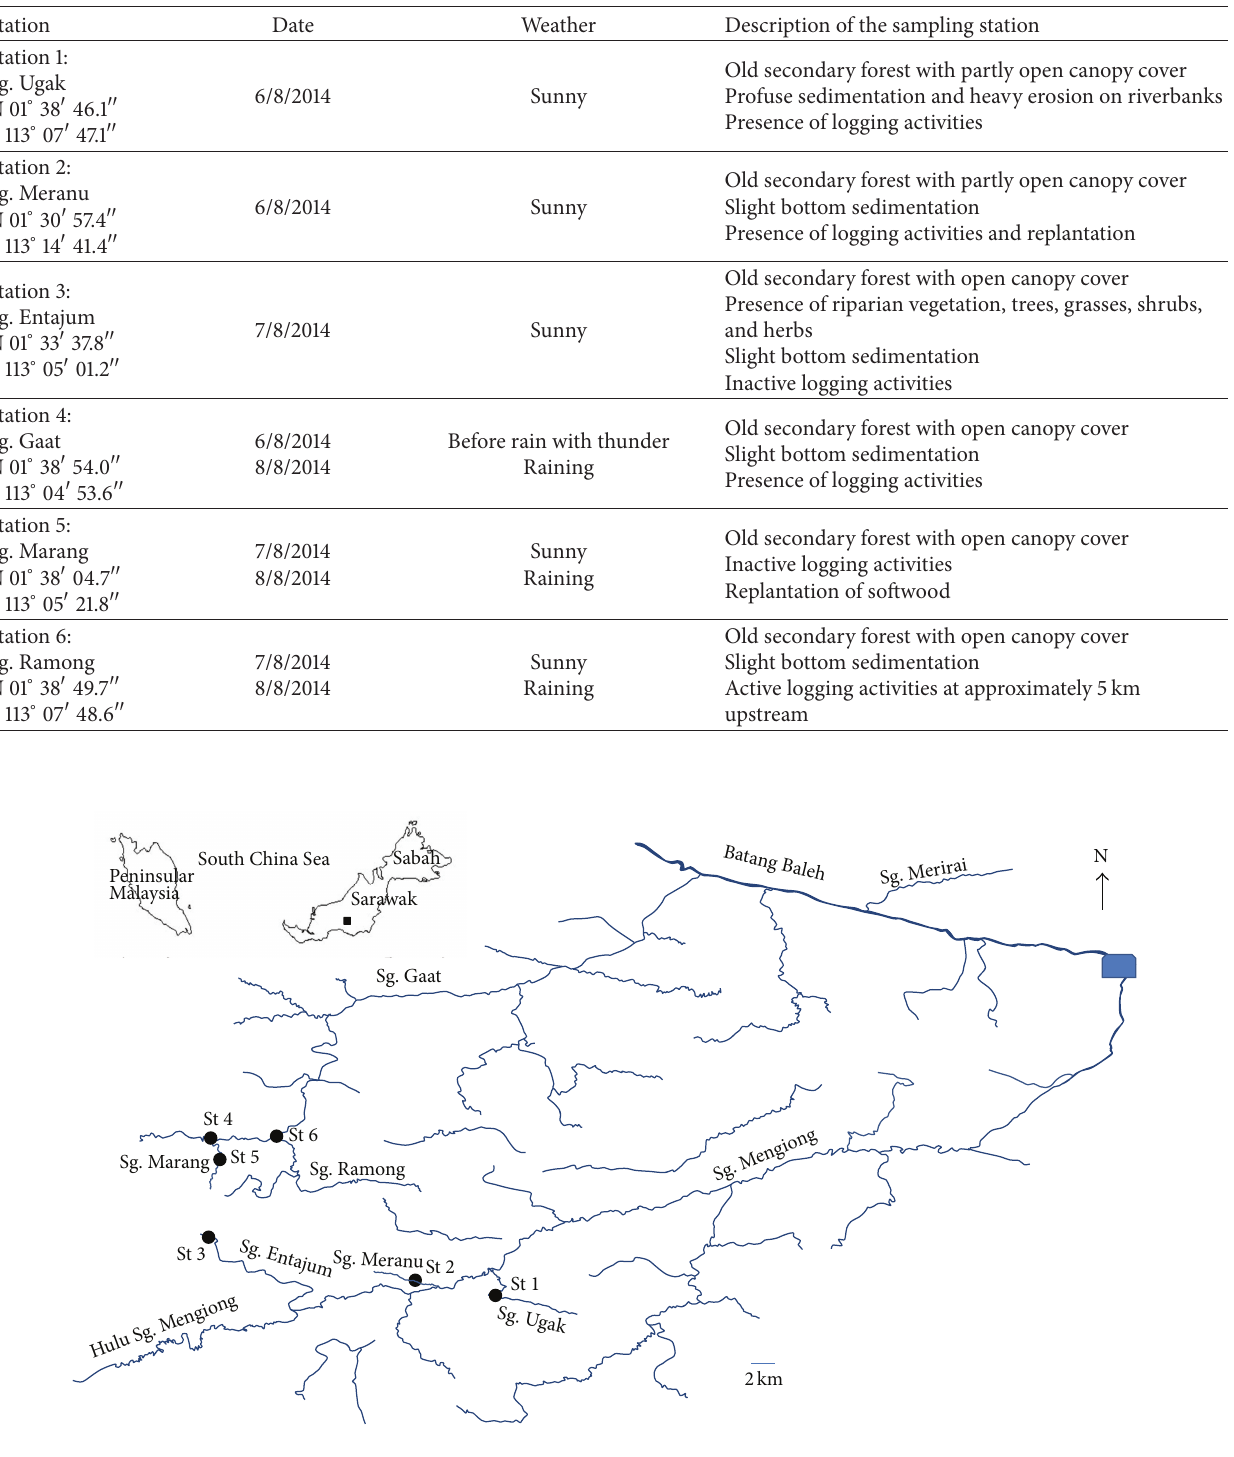
Table 1: The sampling regime and description of the six stations surveyed in the present study.